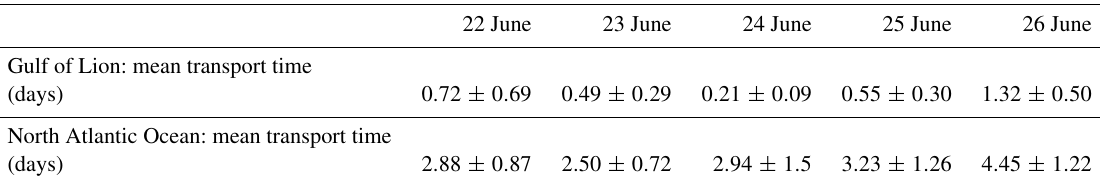
Figure 7. Time series of air mass sources derived from the FLEXPART back-trajectory simulations at 500m from 7 June 2013 to 13 July 2013. The top panel (a) represents the passage of an air mass through the different zones before they reached Ersa. Panel (b) represents the transport time of the air masses from each zone in (a) to Ersa. Table 1. Transport time (mean ± standard deviation) from the Gulf of Lion and North Atlantic Ocean to the Ersa station obtained from FLEXPART simulations analyses (see Sect.